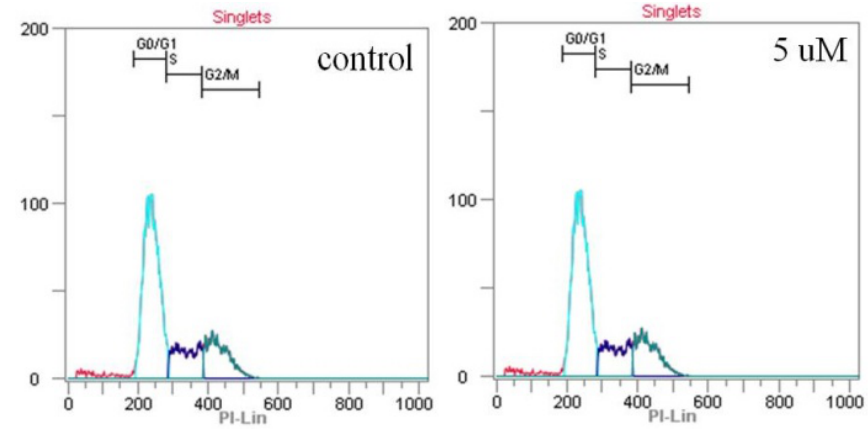
Figure 6. Cell cycle analysis of MCF-7 cells with treatment of falcarindiol. After 24 h